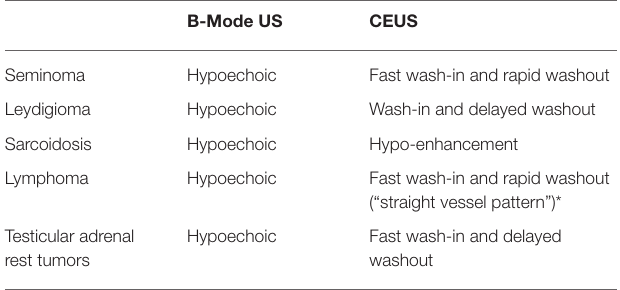
TABLE 2 | Differential diagnosis of testicular sarcoidosis with the most frequent testicular lesions on B-Mode ultrasound and contrast-enhanced